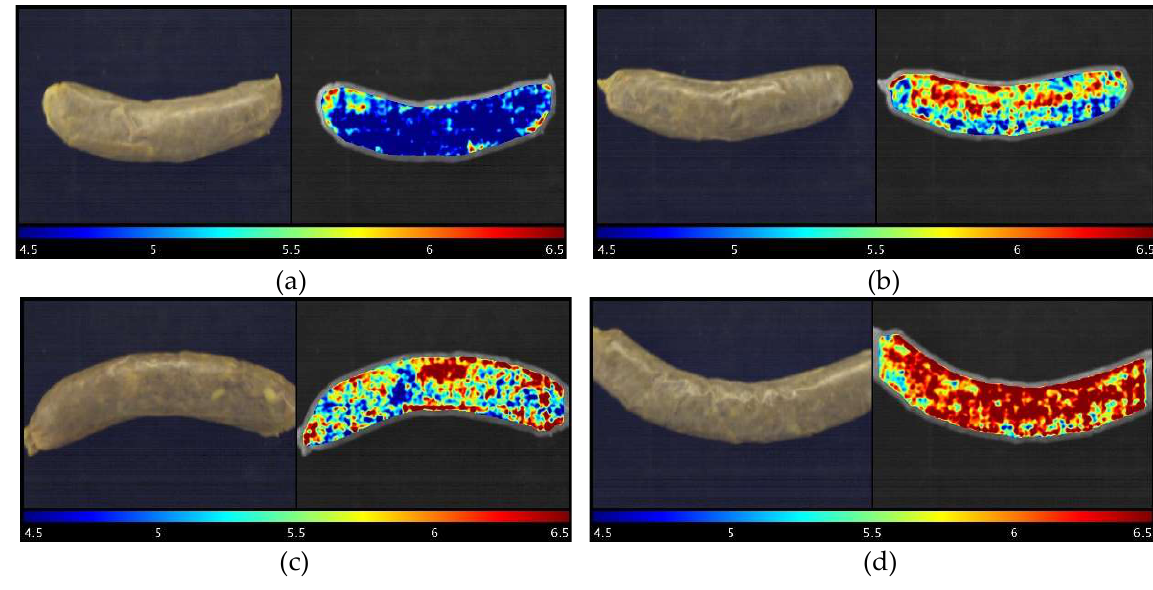
Figure 6. RGB images (left) and visualization of pH prediction map (right) for sausages stuffed in different treated modified casings stored on Day 16. Note: ( a ): Treatment 30 sample, pH = 4.44; ( b ): Treatment 20 sample, pH = 6.17; ( c ): Control sample, pH = 6.24; and ( d ): Treatment 22 sample, pH = 6.46;.